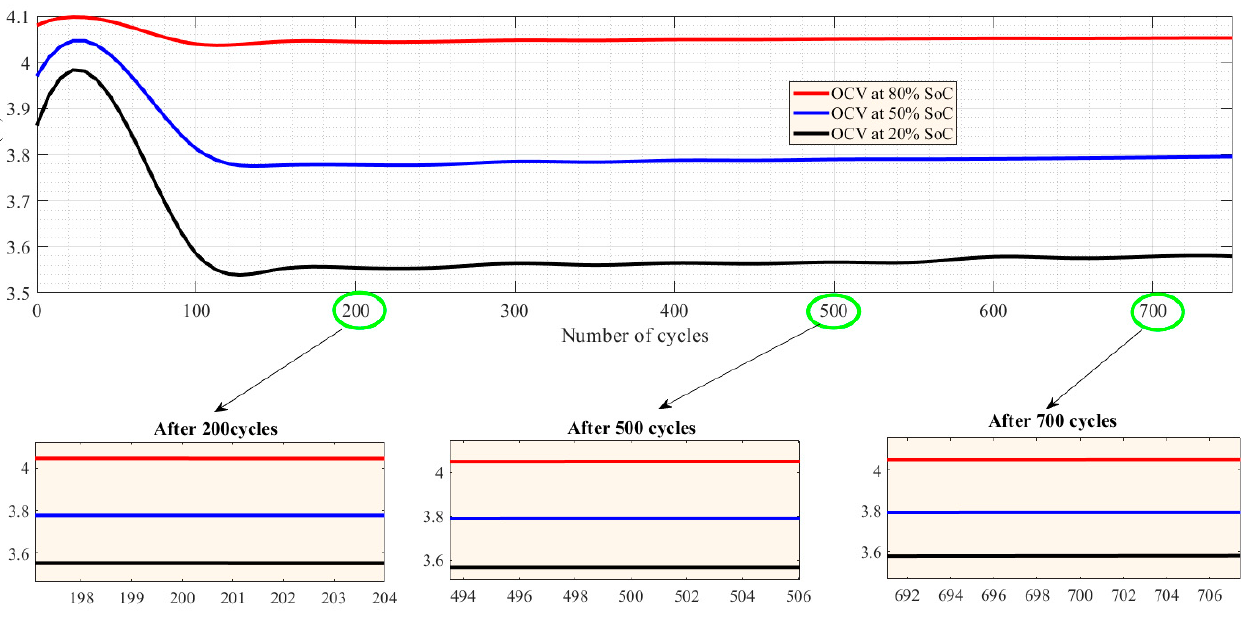
Figure 12. Comparison of the OCV pattern at 25 °C under C/2 charge and 3C discharge test conditions.